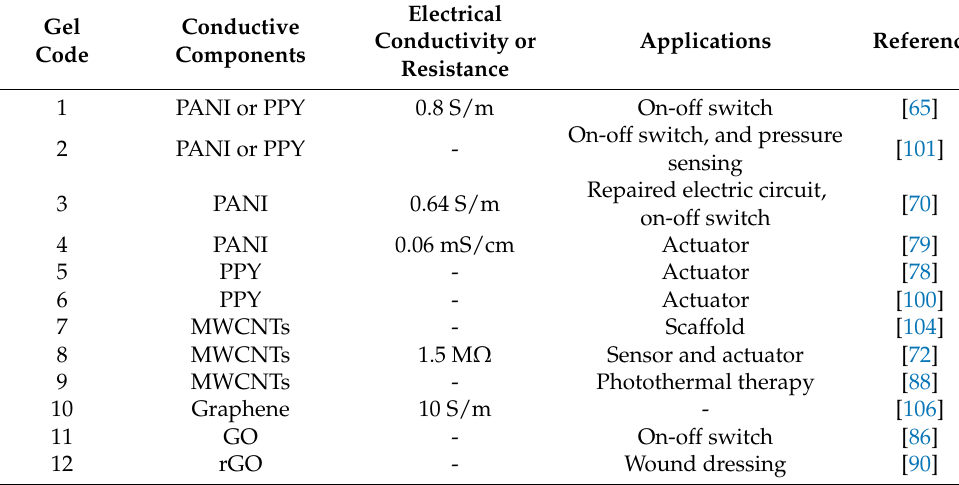
Table 1. Representative PNIPAM-ECHs based on their conductive components. “-” means not